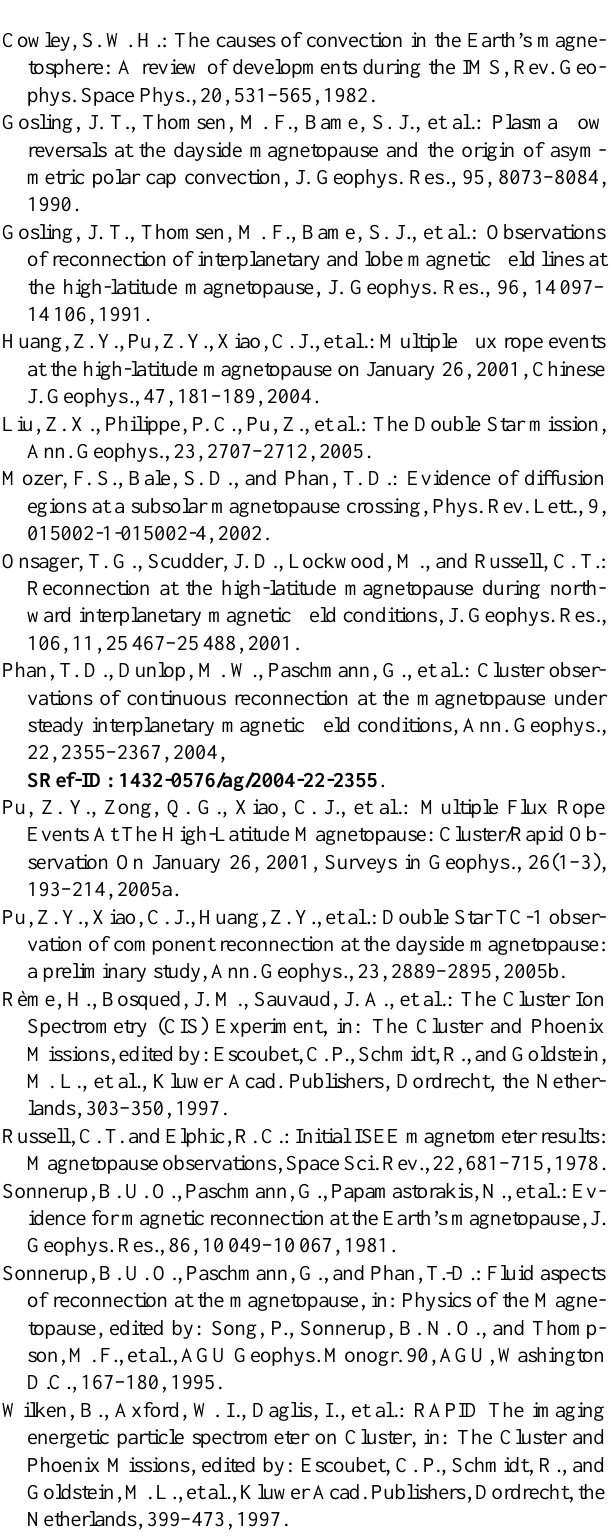
C. J. Xiao et al.: Multiple Flux Rope Events at the Magnetopause Table 2. Average values of the IMF and solar wind plasma param- eters for 18 March and 26 Jan events. The arrow means that the parameter changes with time. Parameter